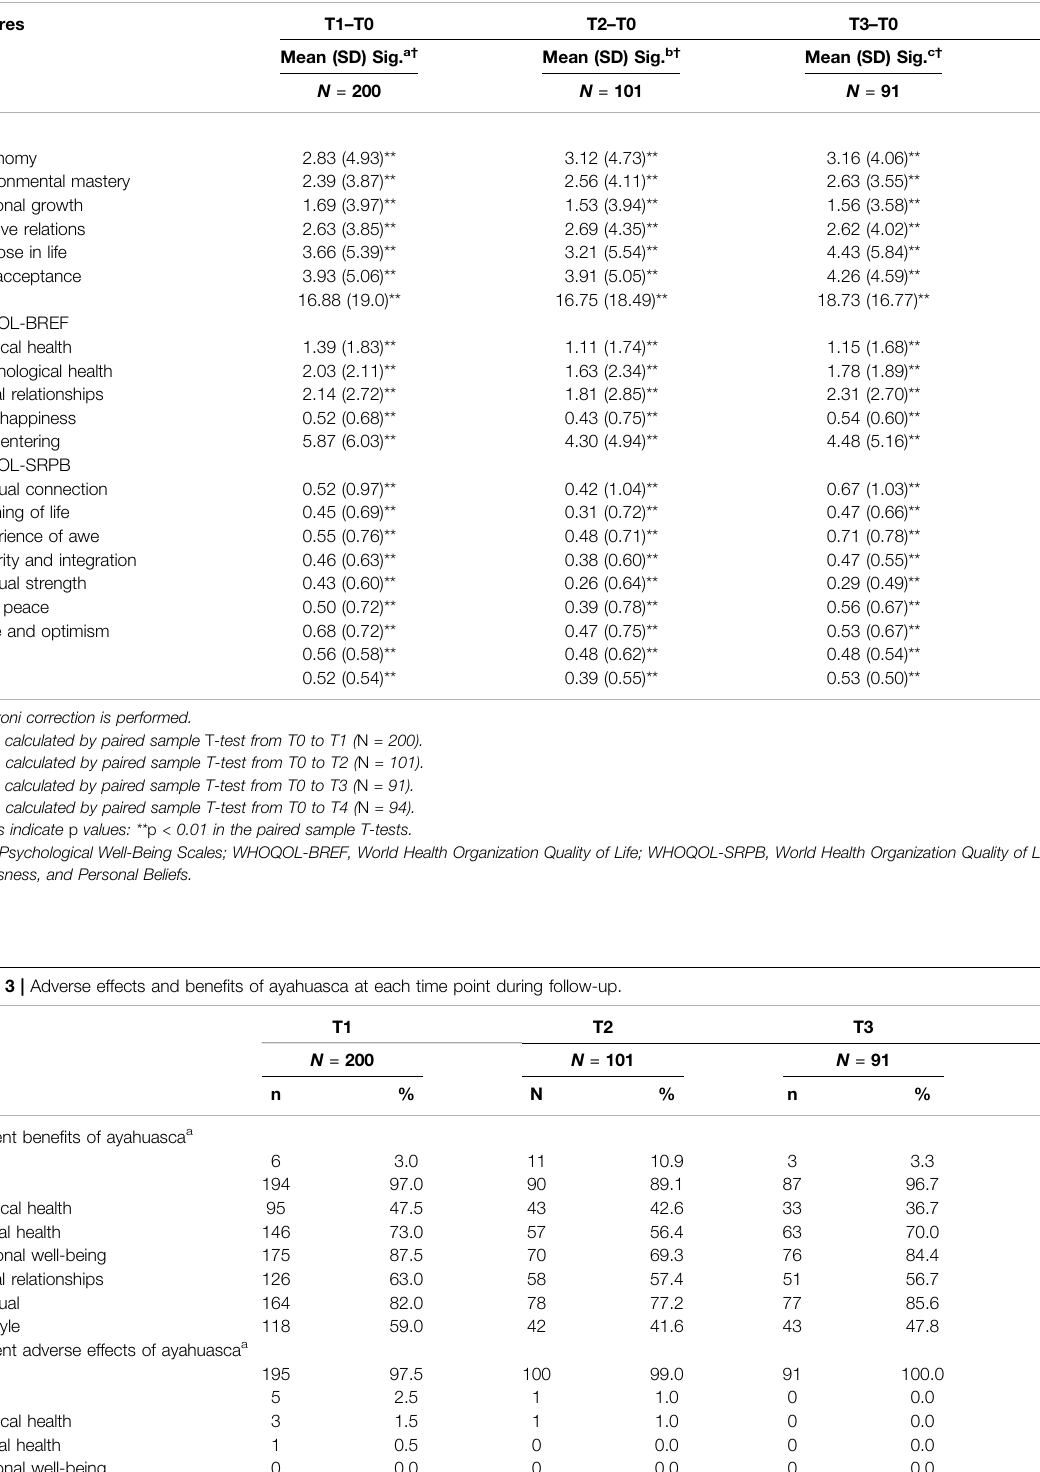
TABLE 2 | Outcome of repeated measures at baseline (T0) and each time point during follow-up. Values are given as means differences (with standard